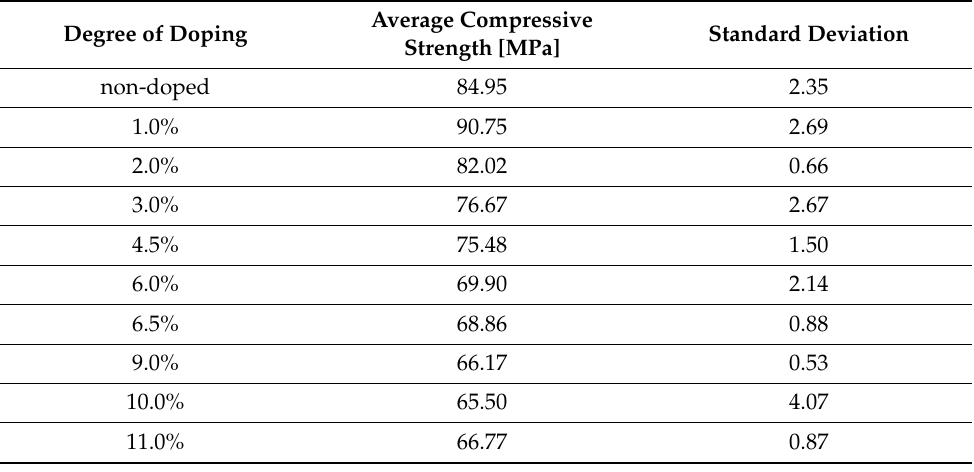
Table 3. Comparison of the average compressive strength values depending on the doping level.